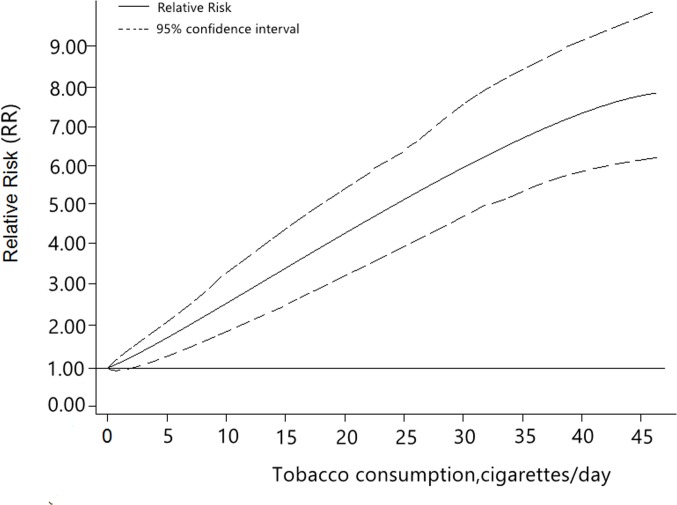
Relative risk function and the 95% confidence intervals for the association between tobacco consumption per day and HNC.